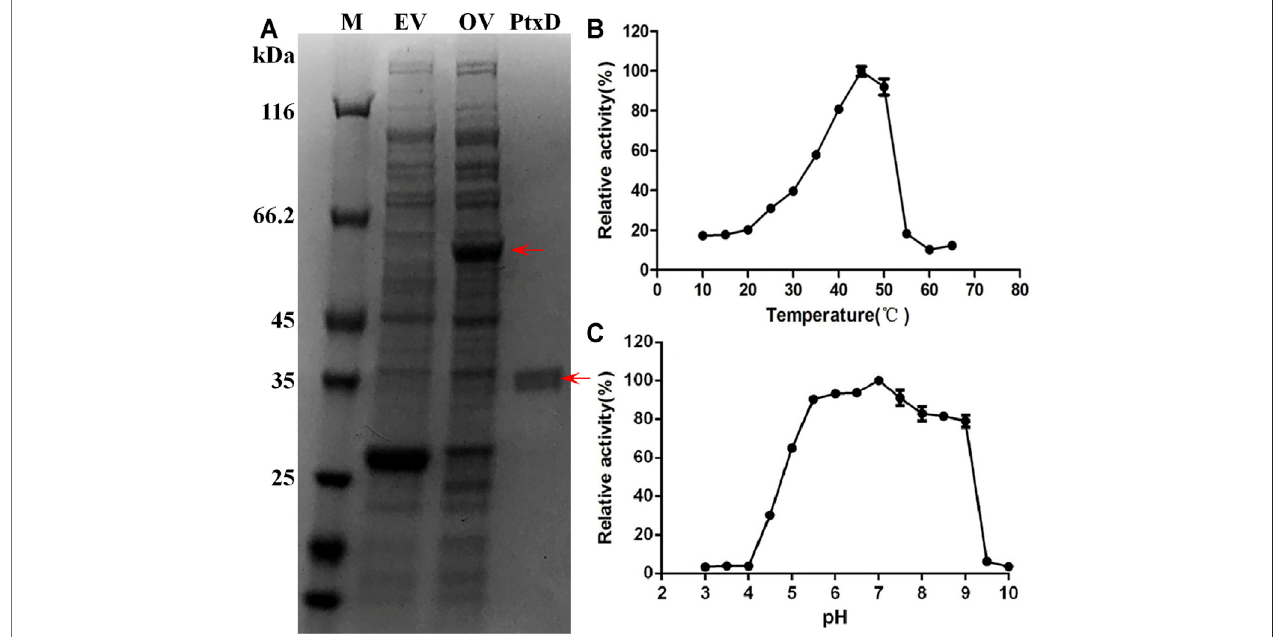
FIGURE 1 | Puri fi cation and biochemical properties of PtxD R4506 . (A) Expression and puri fi cation of the recombinant PtxD R4506 from E. coli . The soluble fraction consisting of cellular proteins and puri fi ed PtxD were loaded onto SDS-PAGE. M, protein maker; EV, empty vector (pGEX-6P) control; OV, PtxD overexpression vector (pGEX-6P-PtxD);PtxD,puri fi edPtxD R4506 protein. (B) TheeffectoftemperatureonPtxD R4506 activity. (C) TheeffectofpHonPtxD R4506 activity.Alltheassaywasdonein triplicate, and the results were shown as means ± SD.